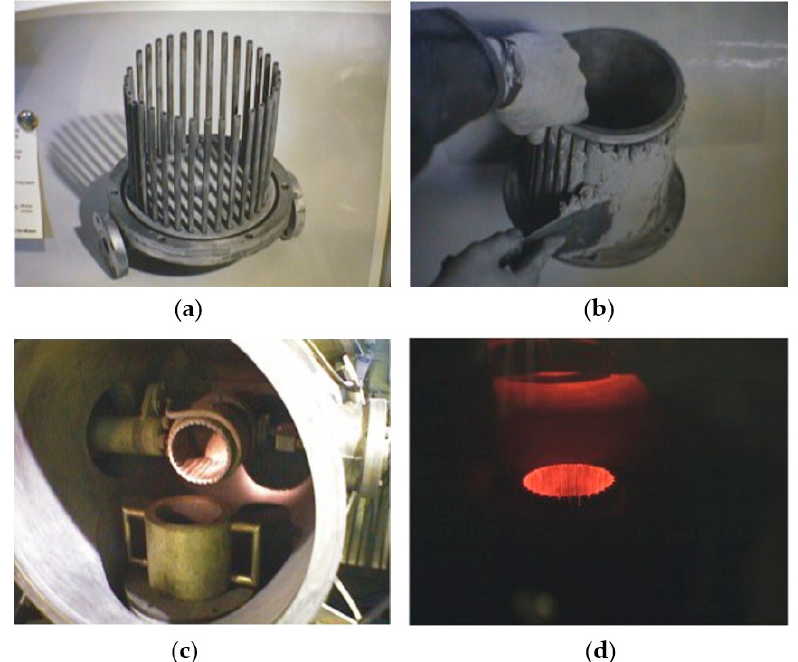
Figure 8. Images of skull melting: ( a ) water-cooling Cu rods, ( b ) application of refractory outside the crucible, ( c ) setup of a crucible and a mold in a vacuum chamber, and ( d ) during operation (Courtesy of Albany Research Center, Albany, OR, USA).